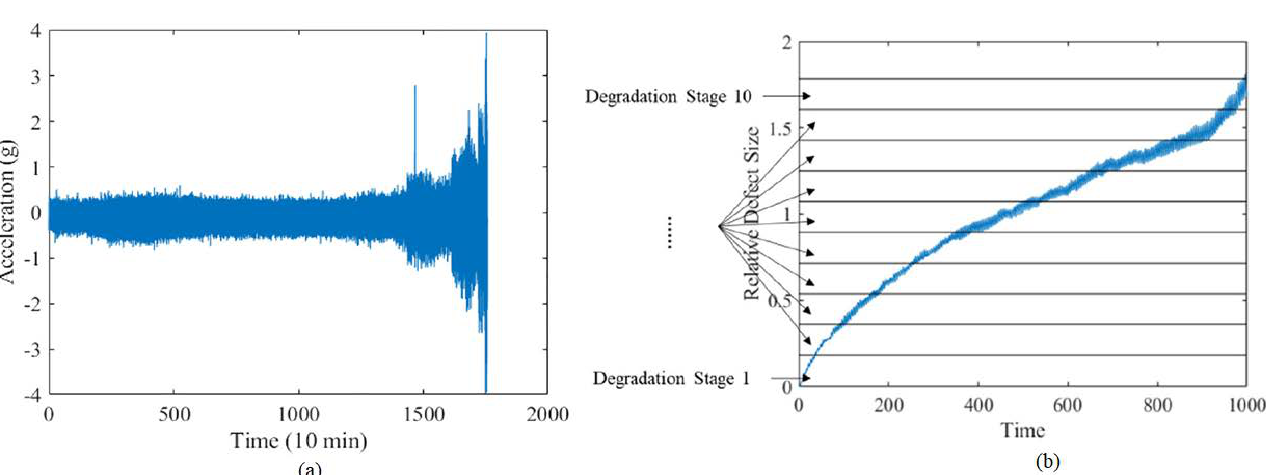
Figure 54. ( a ) Prognosis result for prediction of RUL. ( b ) Zoom view [132]. In [133], the writers proposed a deep neural network (DNN) for the diagnosis of bear- ing faults. Vibration signals were employed for feature extraction to convert multi-domain images and fed to the DNN for the classification of bearing faults. In [134], the authors proposed health monitoring of ball bearings using Hilbert–Huang, support vector ma- chines SVM, and support vector regression SVR. Hilbert–Huang was implemented to haul out attributes from stationary vibration signals. SVM and SVR were utilized to classify and estimate the RUL of bearings, respectively. In [135], the authors suggested the sparse representation theory incorporated with kernel functions of support vector machines (SVM) for the diagnosis of bearing faults. Root mean square error (RMSE) and mean square correlation coefficient (MSCC)were uti- lized for feature extraction optimized by PSO to obtain significant information for training purposes. In [136], the authors recommended a Bayes classifier for the classification of